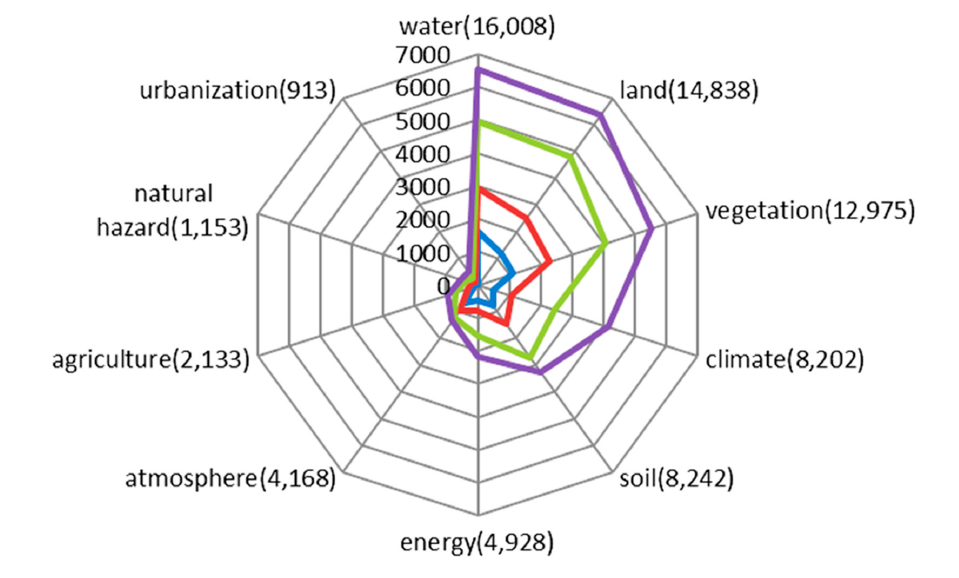
( C ) Annotation: The blue line represents 1999–2004, the red line represents 2005–2010, the green line represents 2011–2016, the purple line represents 2017–2021.